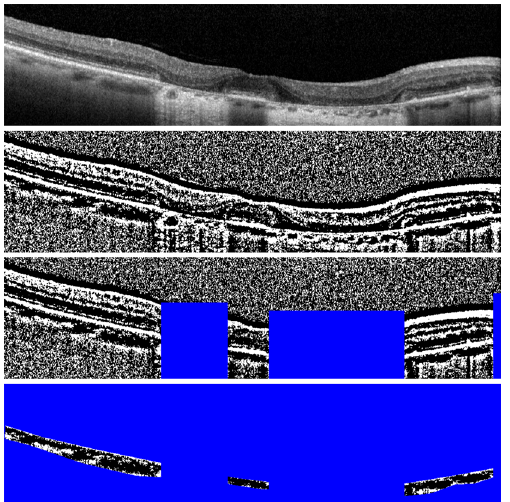
Figure 2. Image processing for calculation of choroidal vascularity index (CVI). OCT B-scans were imported into ImageJ software (National Institute of Health, Bethesda, MD) and binarized with Niblack’s autolocal threshold. Areas of hyper- and hypo-transmission were excluded from the final ROI. In this case CVI is 0.69.